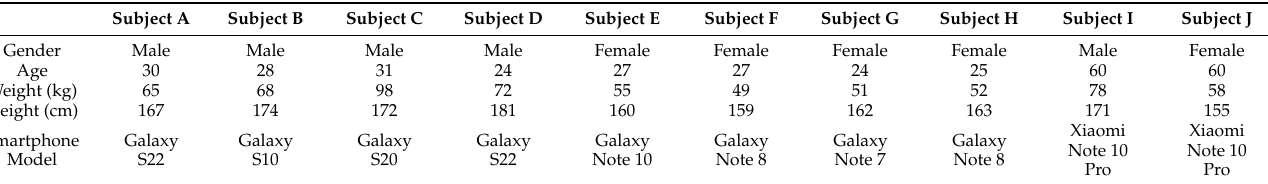
Table 3. Subject’s body information and smartphone